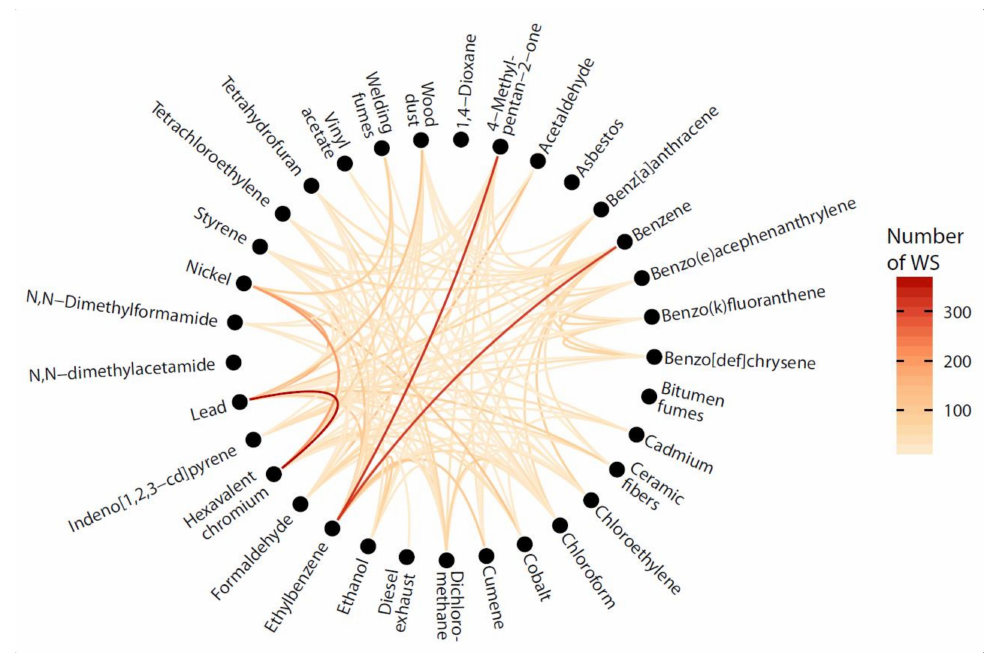
Figure 1. Co-occurrence chart of carcinogen exposures (excluding quartz and cristobalite) dis- playing co-occurrences with a minimum of 10 WS exposed. Darker shades of colors denote more frequent